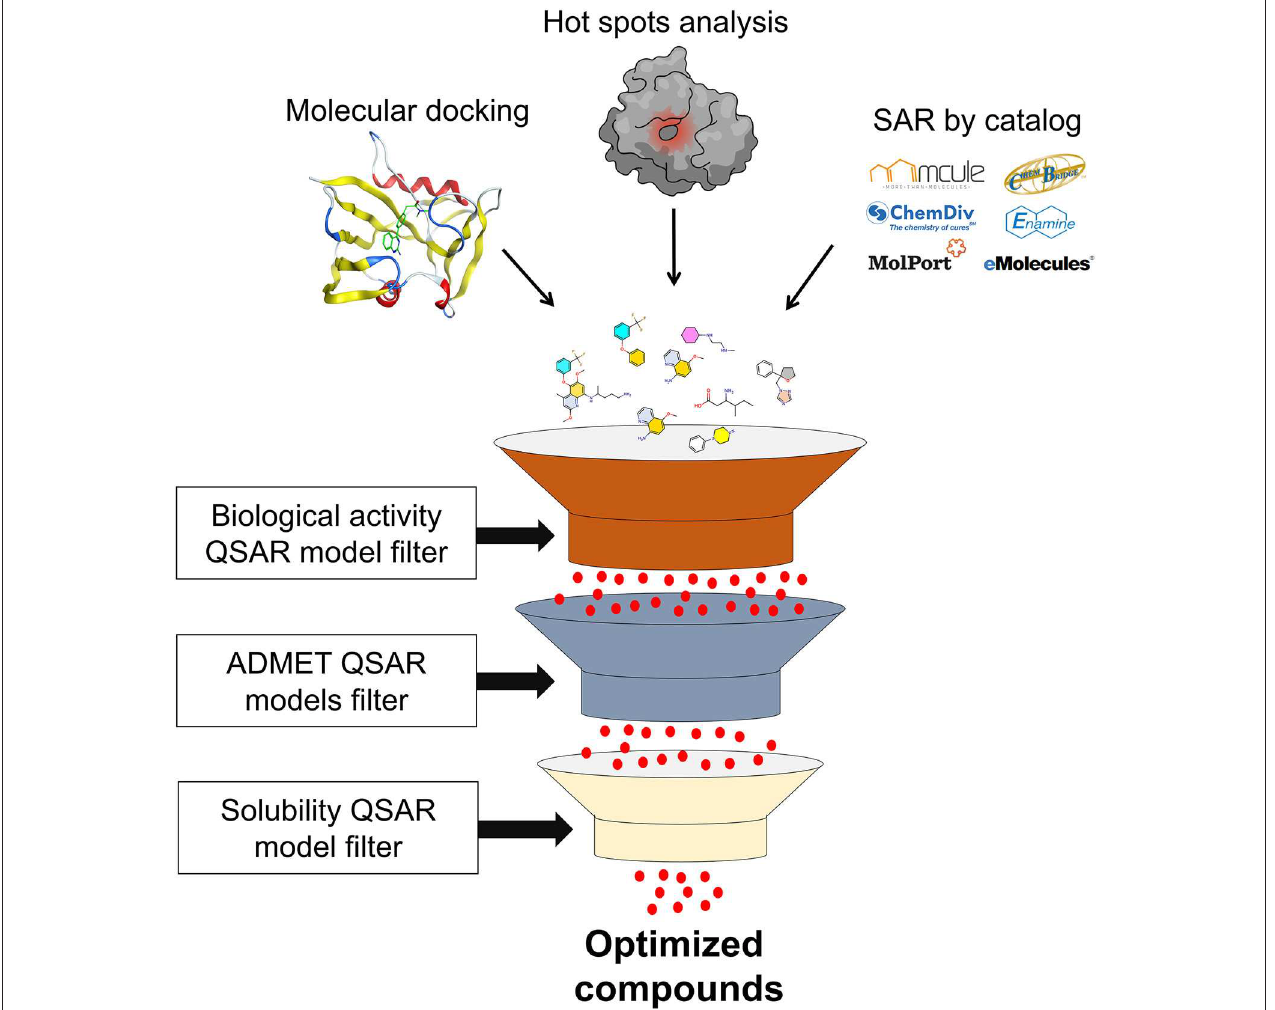
FIGURE 6 | Cascade virtual screening filtering optimized compounds with the desired activities and